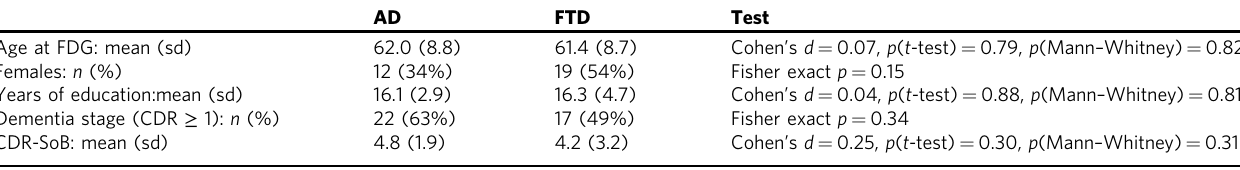
Table 2 Demographic information for FTD and AD individuals included in FDG-PET